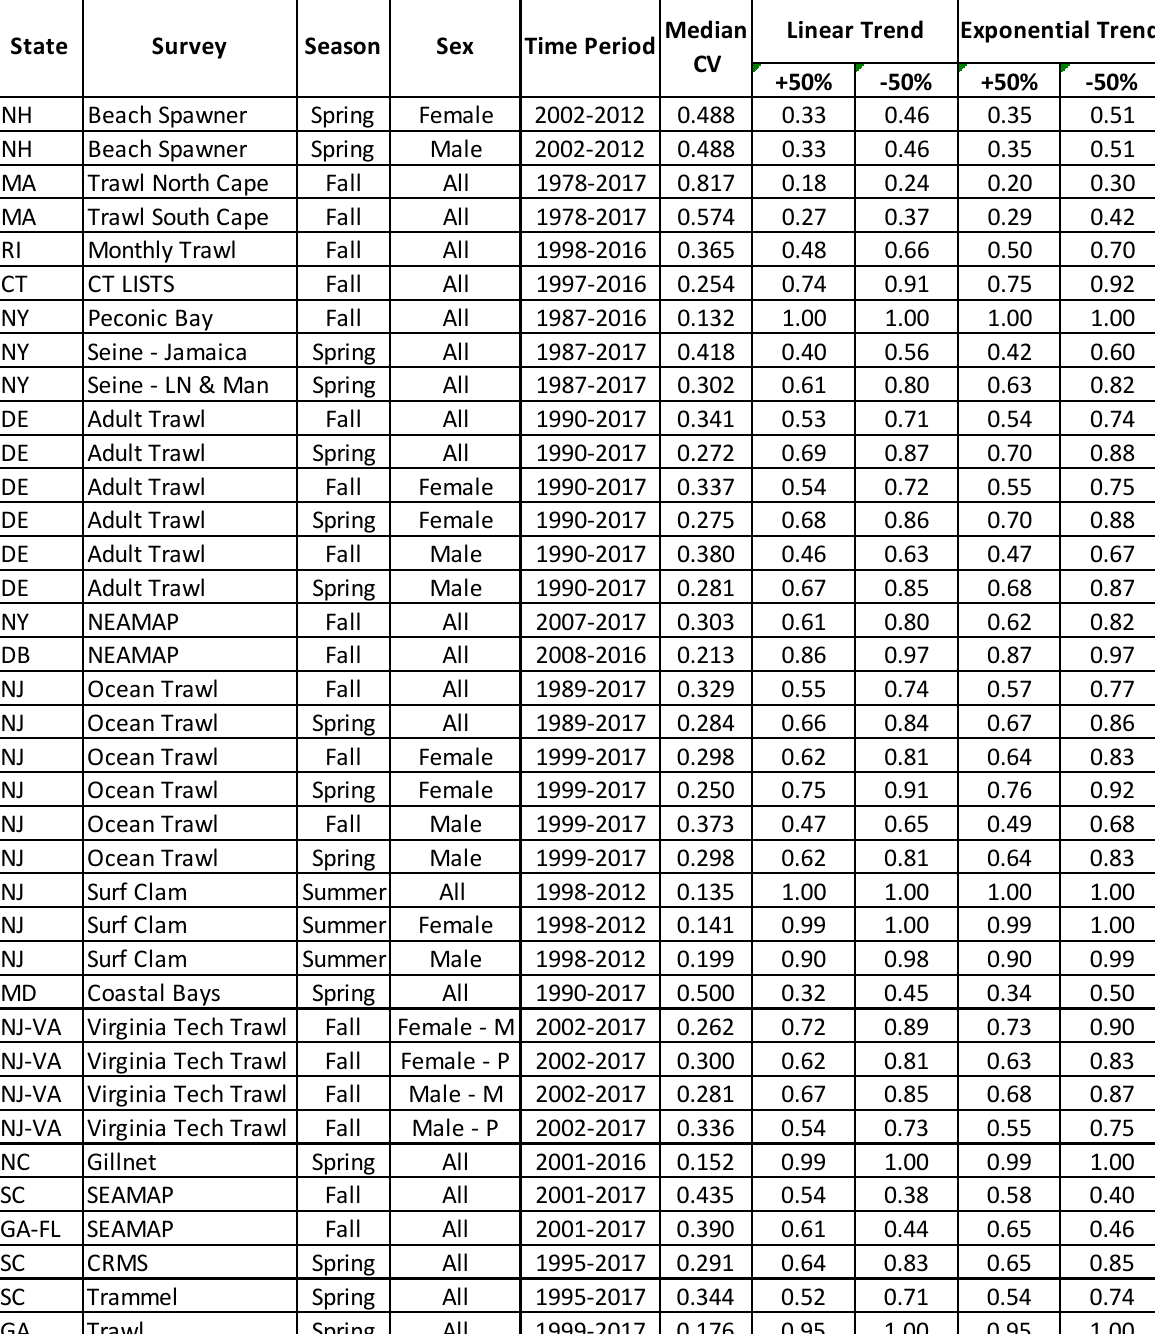
Table 36. Results of the power analysis by survey for linear and exponential trends in horseshoe crab abundance indices over a twenty-year period. Power were calculated as the probability of detecting a 50% change following the methods of Gerrodette (1987). Sex includes all mature horseshoe crab or multiparous (M) or primiparous (P) if